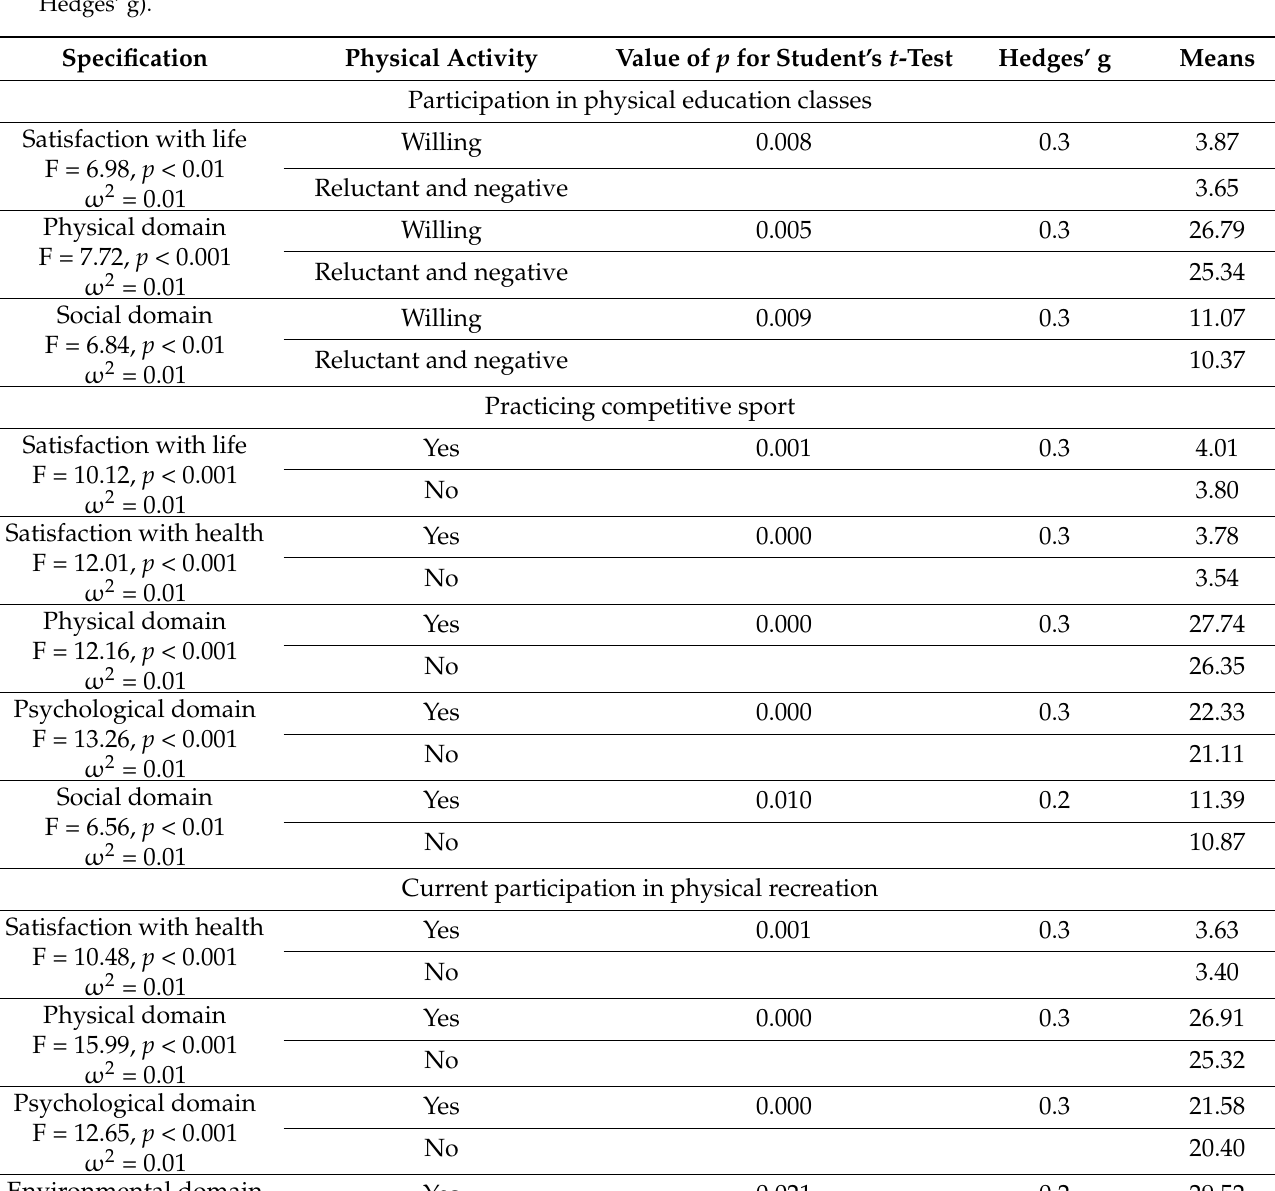
Table 2. Physical activity of respondents in the past and present and their quality of life (F-test, ω 2 , Student’s t -test, Hedges’